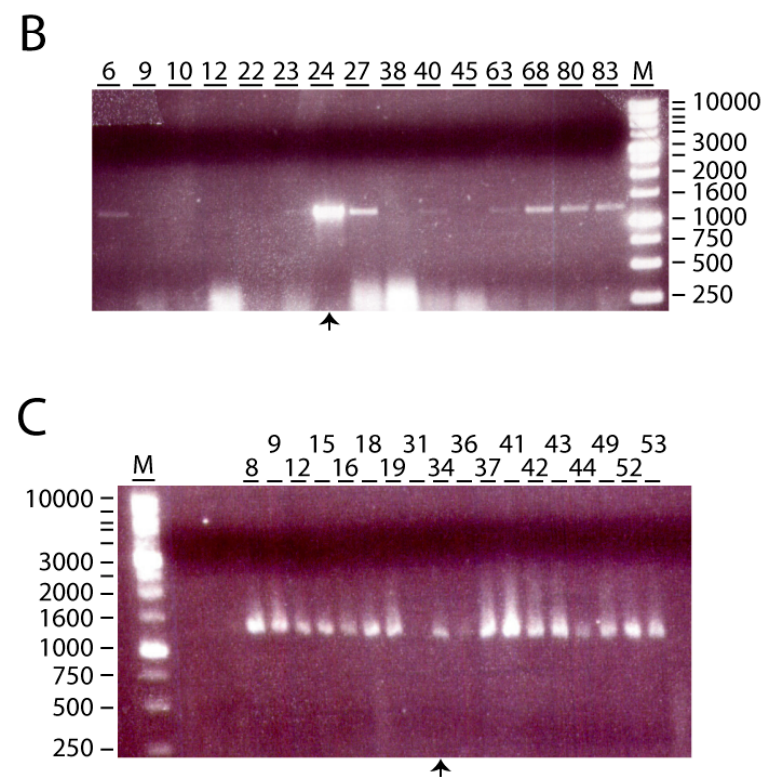
Figure 2. Generation of dck1 knockin strains, ( A ) Schematic representation of the strategy used for the generation of dkc1 knockin strains by homologous recombination. The genomic organization of the dkc1 locus is represented to scale in the upper part indicating the dkc1 gene, the upstream DDB0308306 gene and the intergenic region that contains the putative dkc1 promoter region. The vector used for homologous recombination is represented underneath and includes the blasticidin resistance cassette (BSR) flanked by two Lox sites. Mutated residues are represented as red asterisks on the dkc1 gene. The product of homologous recombination is represented bellow. The location of the oligonucleotides used for verification of homologous recombination is indicated. The Bsr oligonucleotide hybridizes into the blasticidin-resistance cassette while the DKCK5 oligonucleotide correspond to a region of the BBB0308306 genes located upstream of the 5 0 arm of the recombination vector. The position of the oligonucleotides used for amplification and sequencing of the mutated region, SeqF and SeqR, is also indicated. The lowest scheme represents the structure of the locus after removal of the BSR cassette upon expression of the Cre recombinase. Only one Lox site and one short region of the cloning vector remain in the intergenic region. ( B ) DNA was isolated from several clones obtained after homologous recombination using the knockin-1 vector and before BSR cassette removal. The insertion of the BSR cassette in the dkc1 locus was tested by PCR using the oligonucleotides DKCK5 and Bsr, whose location is indicated in Panel A. PCR products were analyzed by agarose gel electrophoresis. The number of each clone is shown in the upper part of the picture. The arrow drown in the lower part of the picture indicates the clone selected for further analysis. The migration of the more relevant fragments of the 1 Kb ladder from Nippon Genetics Europe GMBH (Germany) is shown to the right. ( C ) DNA from clones obtained after homologous recombination using the knockin-2 vector was analyzed for the insertion of the BSR cassette by PCR as indicated in Panel B. Migration of the 1Kb ladder is shown to the left of the panel.